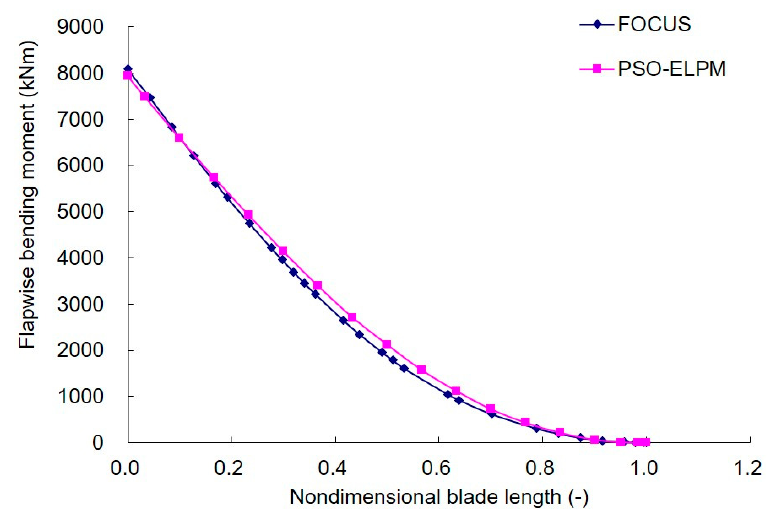
Figure 12. Comparisonof extreme flapwise bending moment along the blade (2.0 MW).